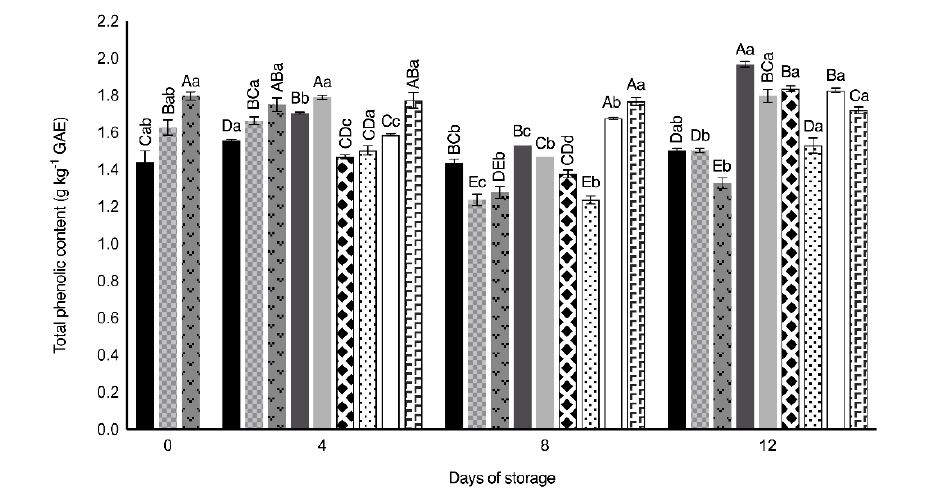
Figure 5. Total phenolic compounds (TPC) of raspberries stored in air (control), treated with UV-C radiation (UV1 or UV2), packaged in MAP (MAP1 or MAP2) and their combinations during 12 d of storage. Values represent mean ± standard deviation ( n = 3). Lower case letters indicate significant differences ( p < 0.05) among days within the same batch. Capital letters indicate significant differences ( p < 0.05) among batches within the same day.